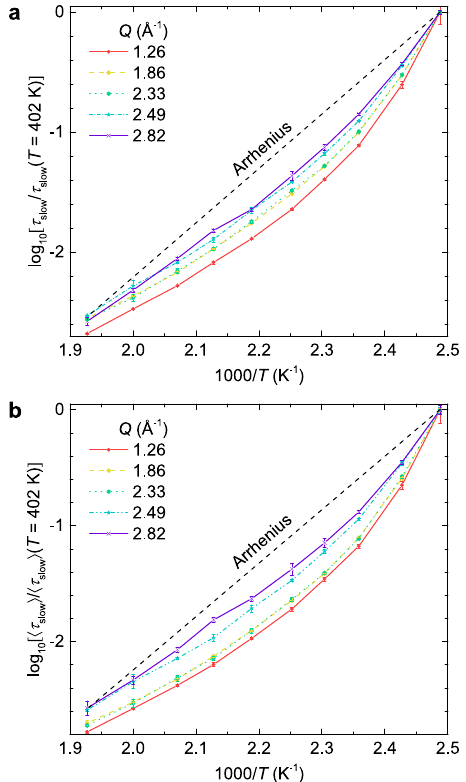
Fig. 5 Direct comparison of the temperature dependence of the relaxation time at different Q ’ s. ( a ) Relaxation time τ slow and ( b ) average relaxation time 〈 τ slow 〉 normalized to that at T = 402 K at representative Q ’ s. Smaller deviations from Arrhenius behavior (the straight dash line) are evident at larger Q ’ s in both cases. Error bars represent one standard error and where not seen they are smaller than the symbol